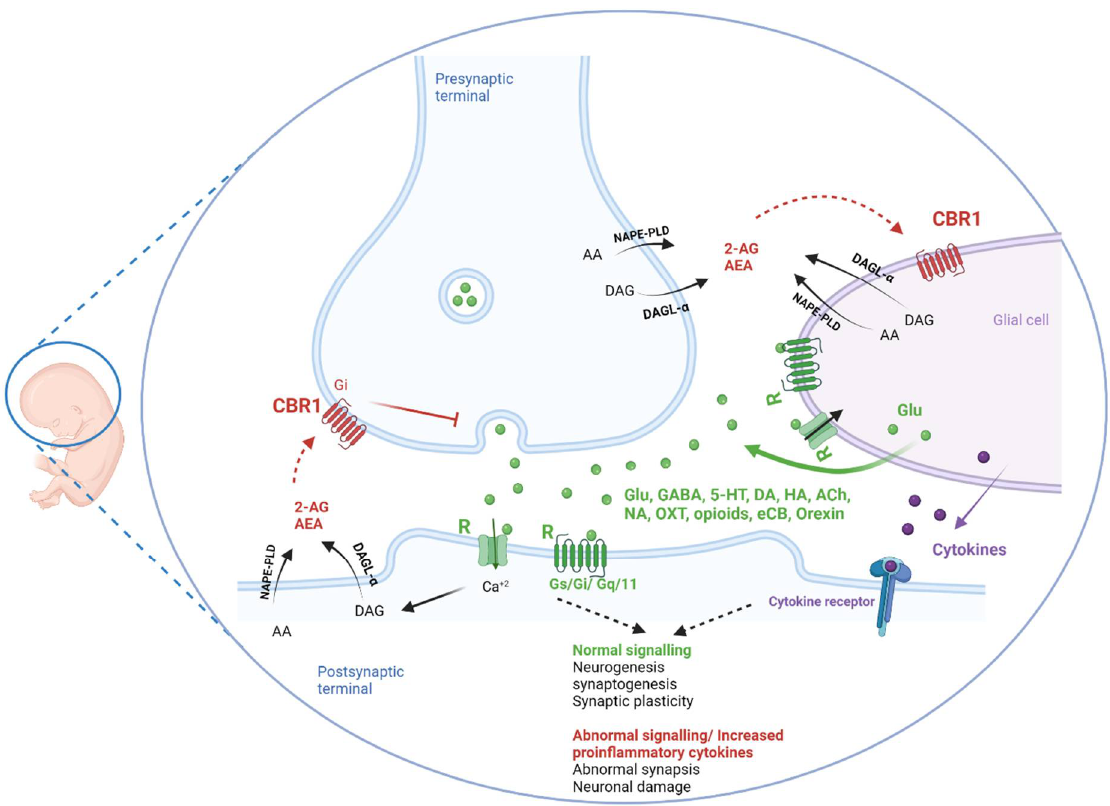
Figure 2. Graphic representation of synapses and microglia interaction during neurodevelopment and possible roles of neuromodulators. R—neuromodulator receptors, 2-AG—2-arachidonoylglycerol, AEA—anandamide, DAGL—diacylglycerol lipase, NAPE-PLD—N-acyl phosphatidylethanolamine phospholipase D, DAG-diaceylglycerol, AA—arachidonic acid, GLU—glutamate, DA—dopamine, NE—norepinephrine, HA—histamine, ACh—acetylcholine, 5-HT—serotonin, OXT—oxytocin. The figure was created in Biorender.com and was licensed for publication in this